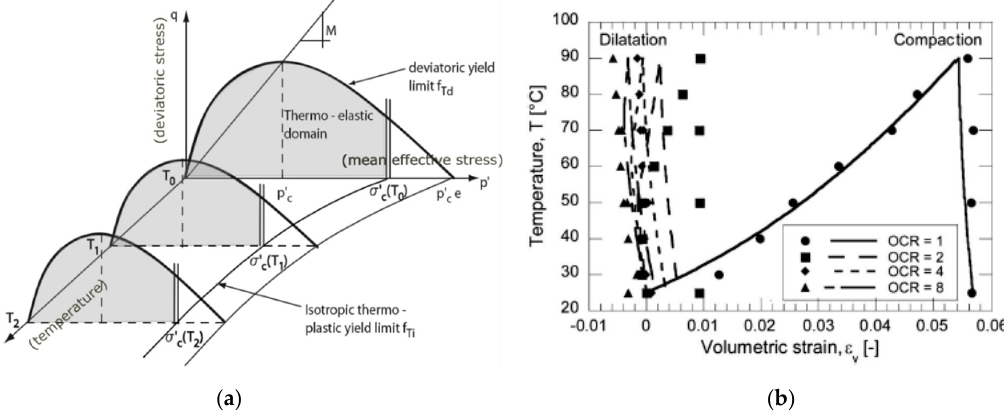
Figure 6. ( a ) Coupled thermoplastic yield limits, ( b ) Numerical simulations and experimental results of a heating-cooling cycle at different degrees of consolidation [157].